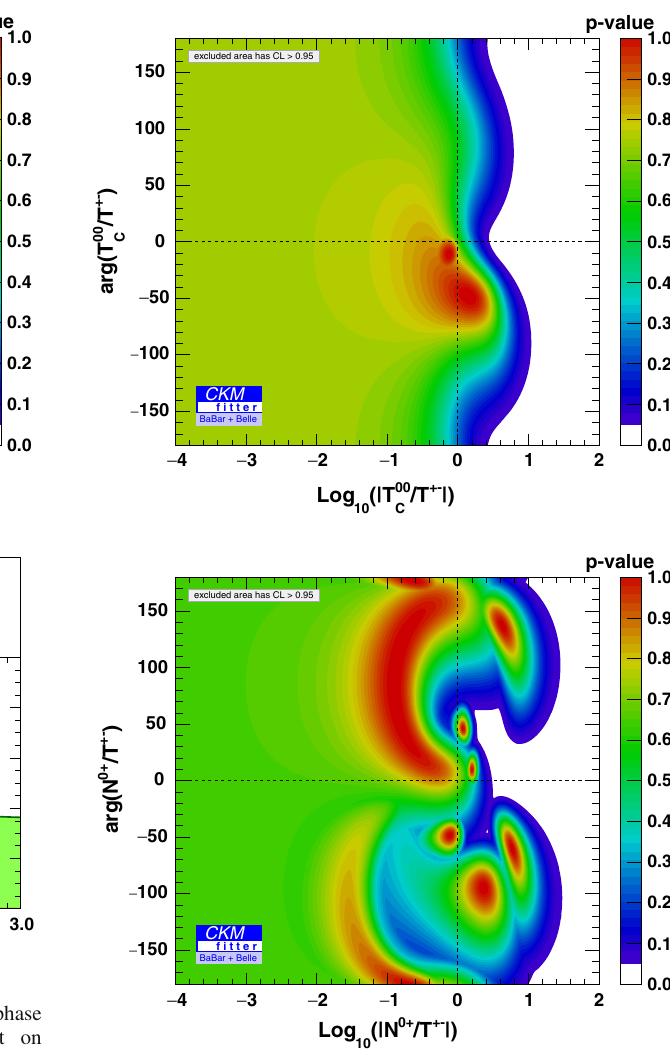
Fig. 11 Two-dimensional constraint on the modulus and phase of the / T +− ( top ) and N 0 + / T +− ( bottom ) T 00 C